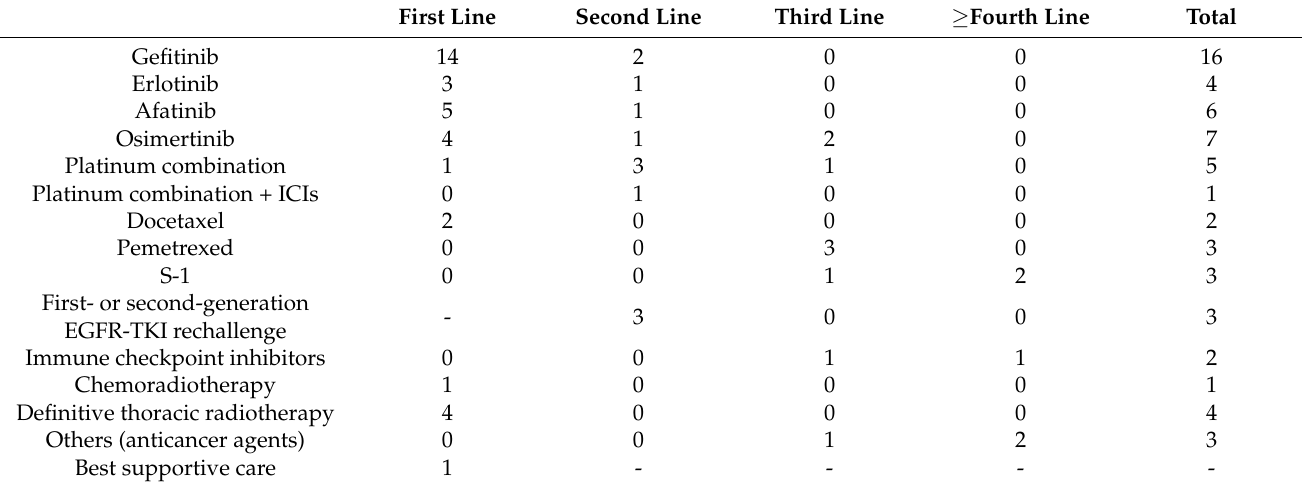
Table 2. Treatments after postoperative